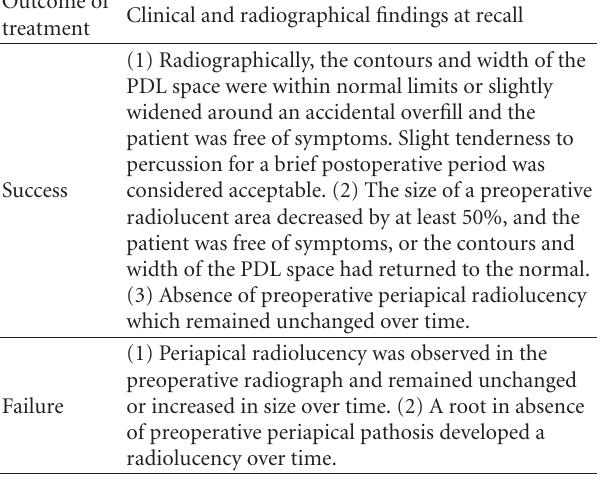
Table 1: Criteria for clinical and radiographic interpretation of success and failure.